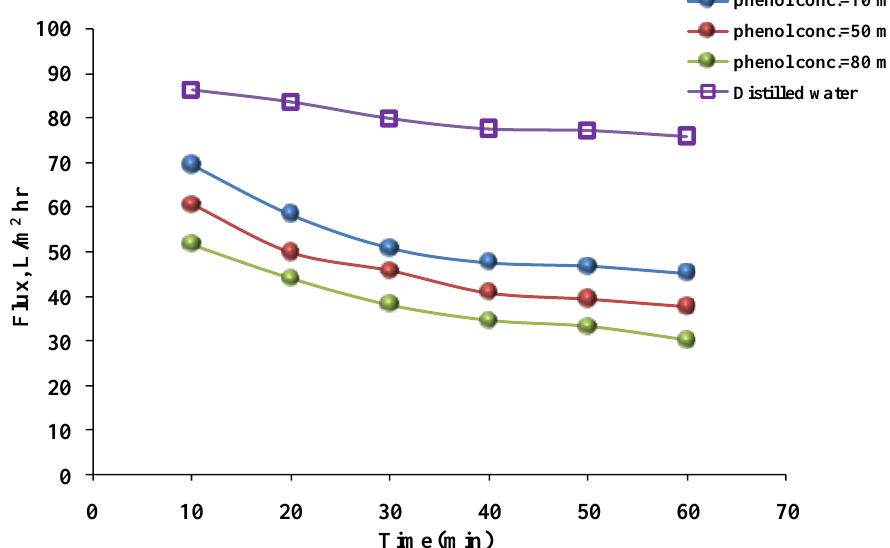
Figure 8. Phenol solution and distilled water’s flux with time for a hydrophobic membrane at different concentrations (pressure = 1 bar, temperature = 30 °C).